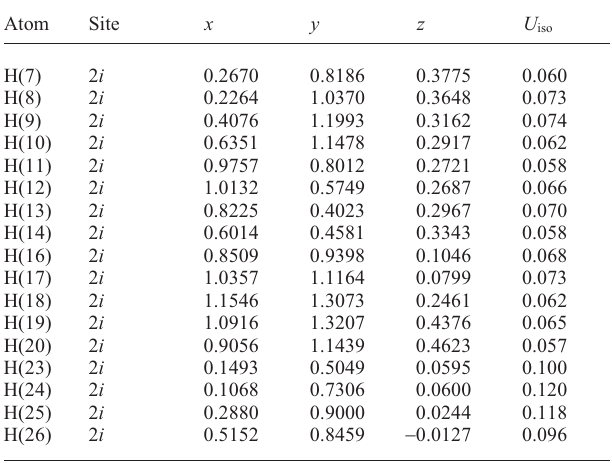
Table 2. Atomic coordinates and displacement parameters (in Å 2 )